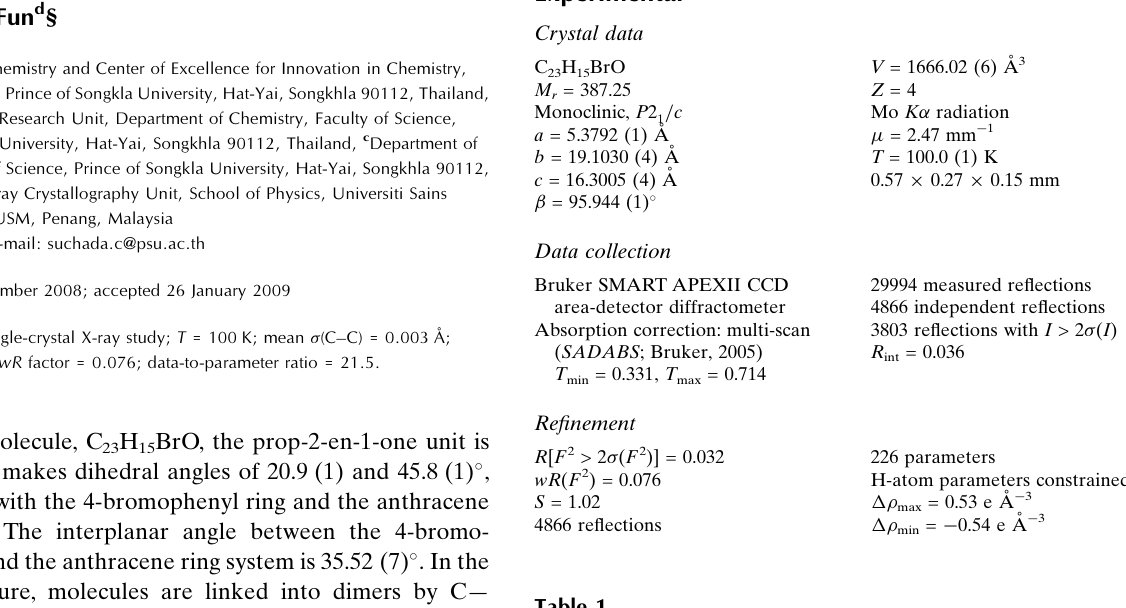
Hydrogen-bond geometry (A˚ , (cid:1)